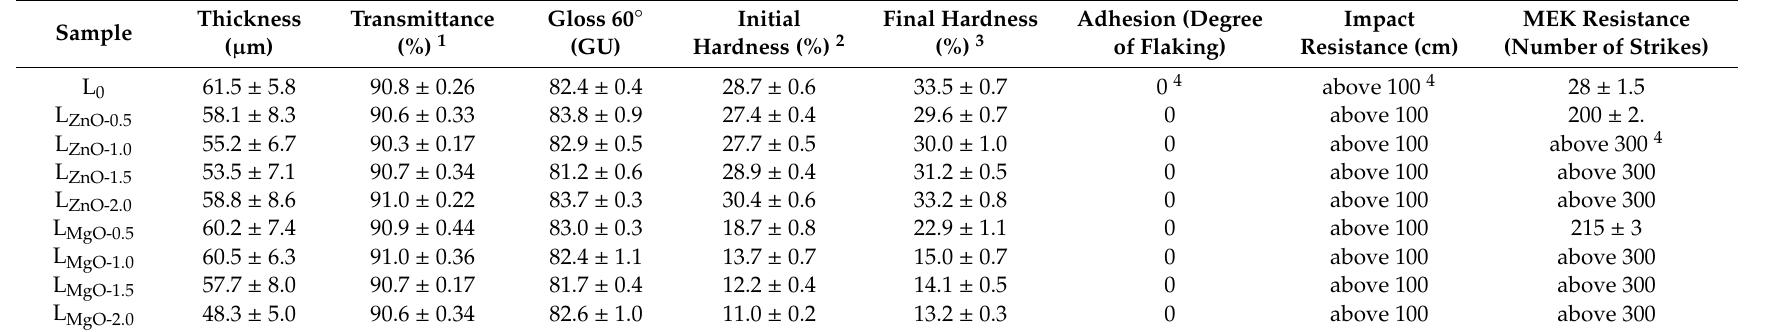
Table 7. Properties of coatings cast on glass